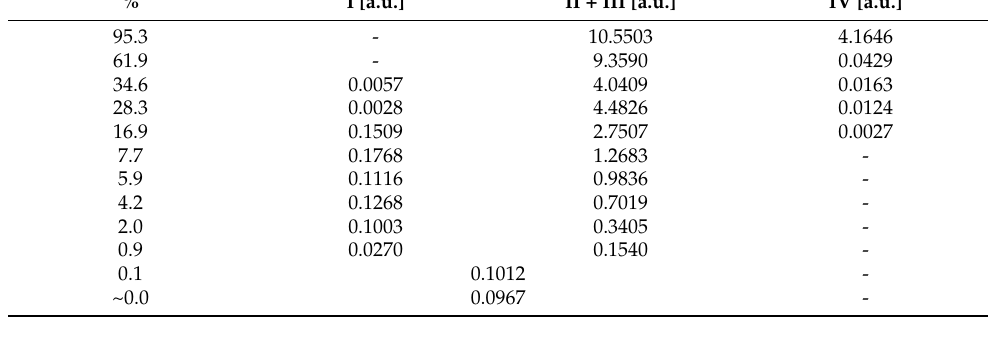
Table 2. Contributions to the signal from different water locations in SBA-15 obtained from the respective integrals of the ILT spectra, expressed in [a.u.] for: I—OH groups, II + III—intra- and inter- pore water, IV—free water.